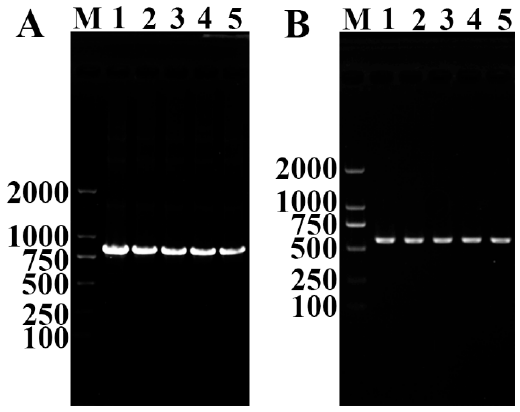
Figure 6. RT-PCR analysis of TsT ( A ) and GAPDH ( B ) mRNA expression at T. spiralis muscle larvae (lane 1), intestinal infective larvae (lane 2), 3-day adult worms (lane 3), 6-day adult worms (lane 4), and newborn larvae (lane